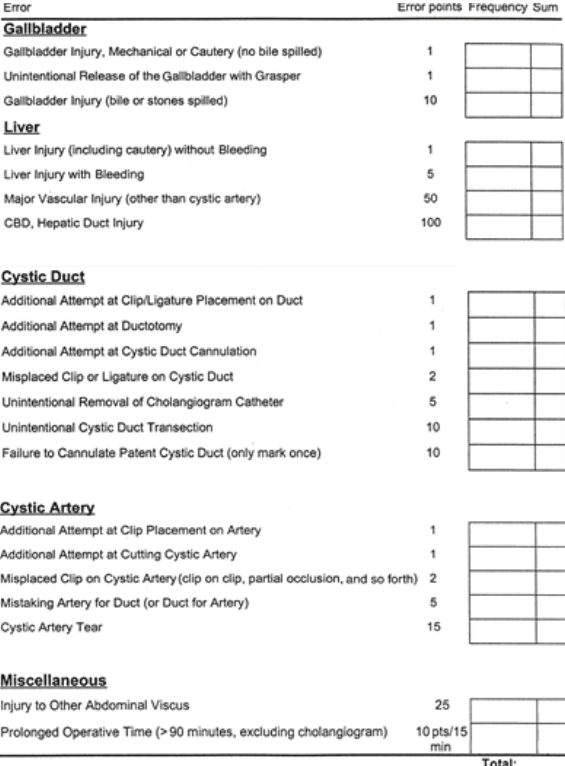
Table 4: Steps and errors in video laparoscopic